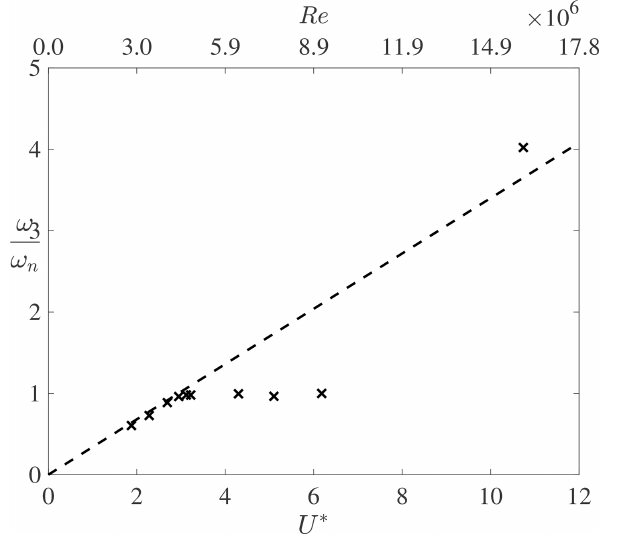
Figure 12. Ratio of the motion frequency to the natural frequency as a function of the reduced velocity for m ∗ = 29 . 6, ζ = 0 . 003, and 1 . 88 ≤ U ∗ ≤ 10 . 74.